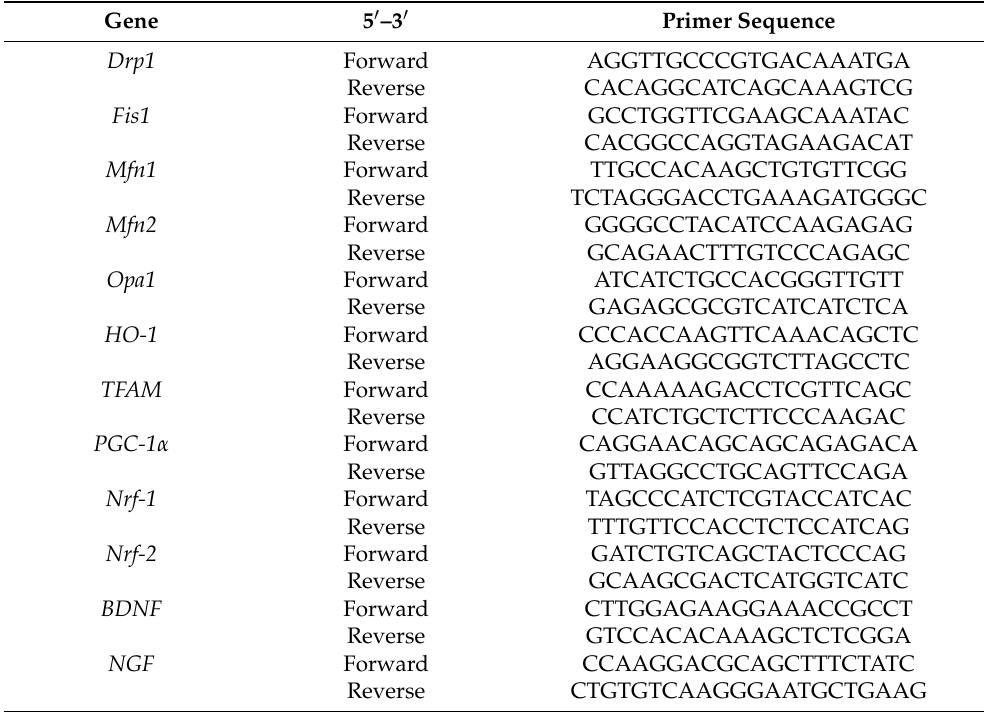
Table 1. Primer sequences used for real-time PCR